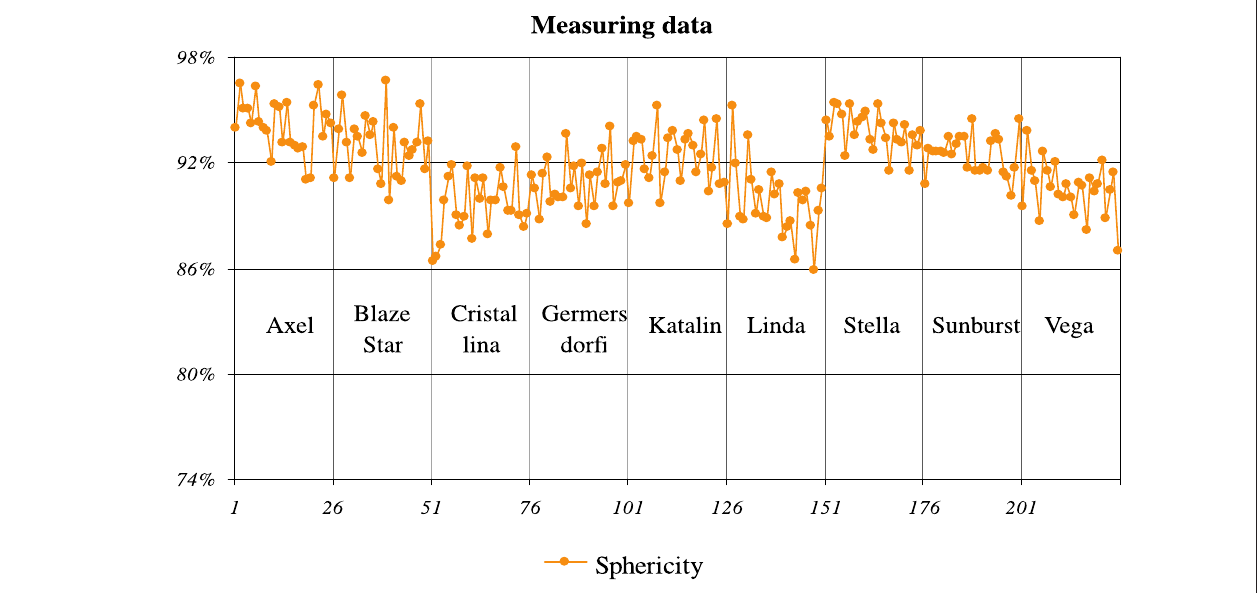
Figure 3. The sphericity of the examined varieties